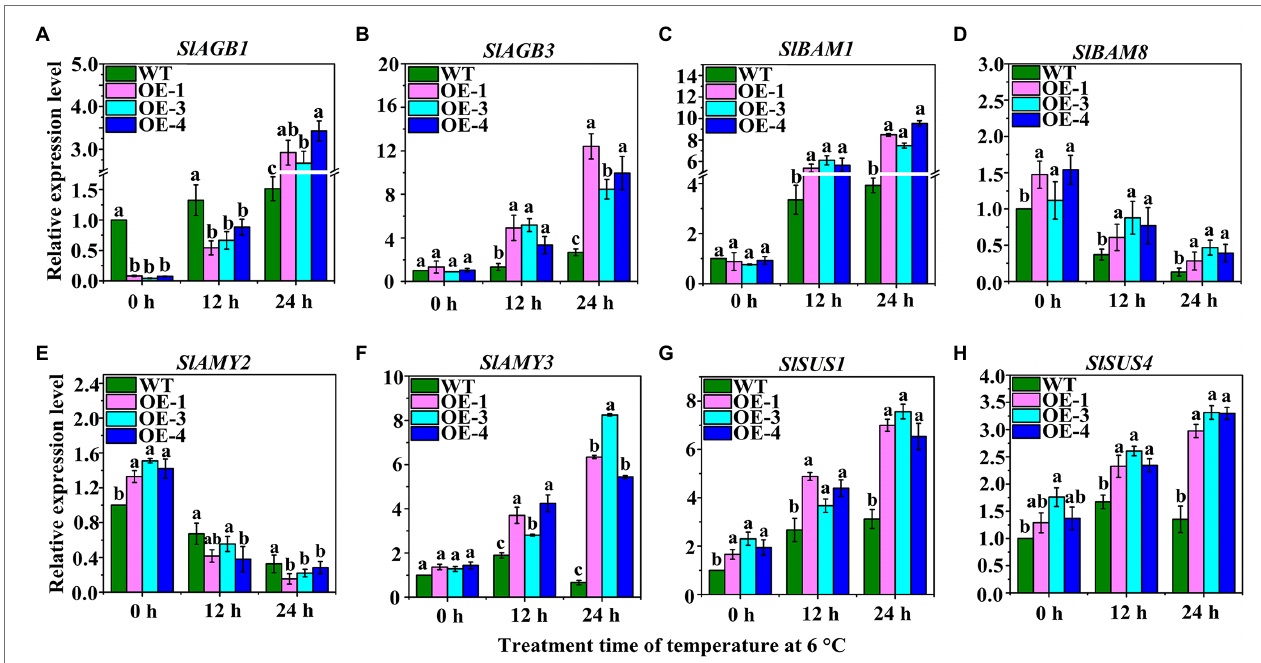
FIGURE 6 | The expression levels of sucrose synthesis- and starch hydrolysis-related genes in OEs under LT treatment. These genes include: (A,B) SlAGB1 and SlAGB3 ; (C,D) , β -amylase genes ( SlBAM1 and SlBAM8 ); (E,F) α -amylase genes: SlAMY2 and SlAMY3 ; (G,H) SuSy genes: SlSUS4 and SlSUS6